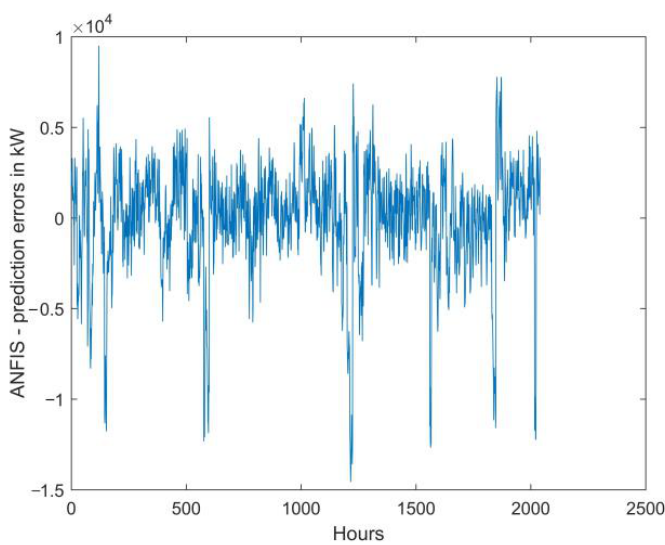
Figure 9. Comparison of Wednesday loads with the prediction.